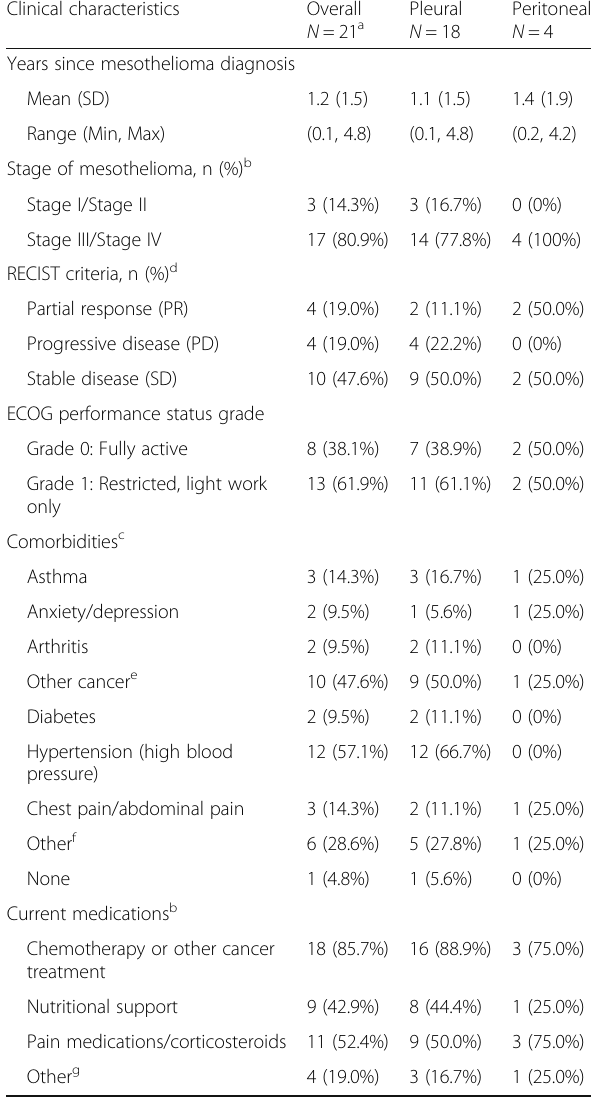
Table 1 Participant self-reported sociodemographic and clinical characteristics